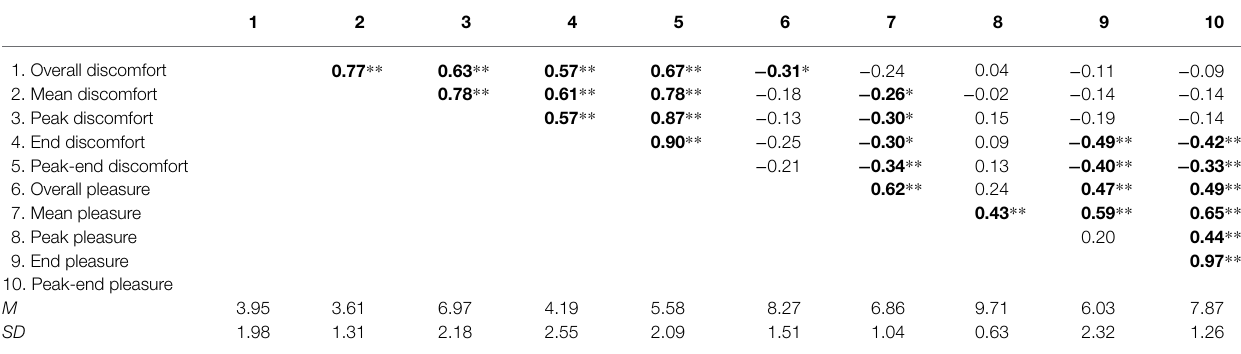
TABLE 2 | Rating results: correlations and descriptive statistics.